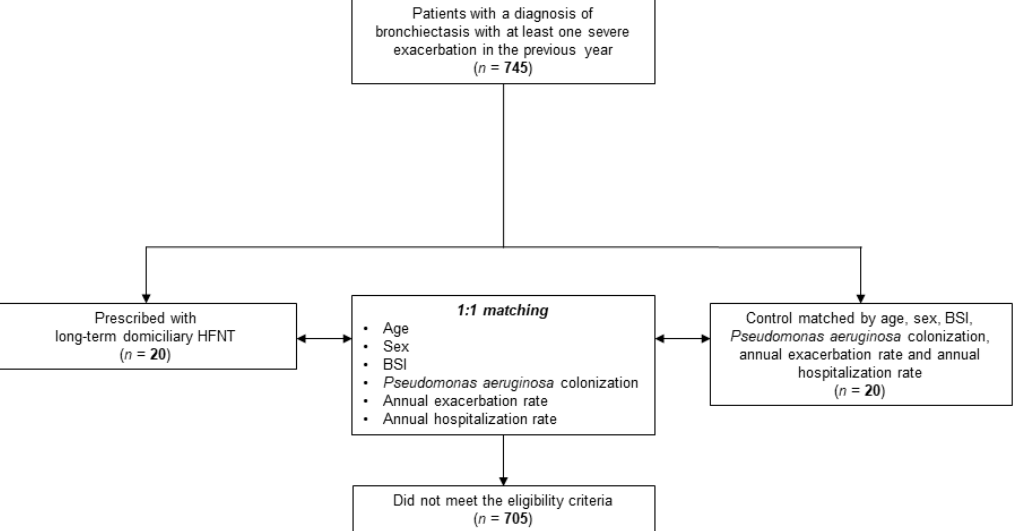
Figure 1. Study flow diagram. Abbreviations: HFNT, high ‐ flow nasal therapy; BSI, bronchiectasis severity index. Table 1. Baseline patients’ characteristics.